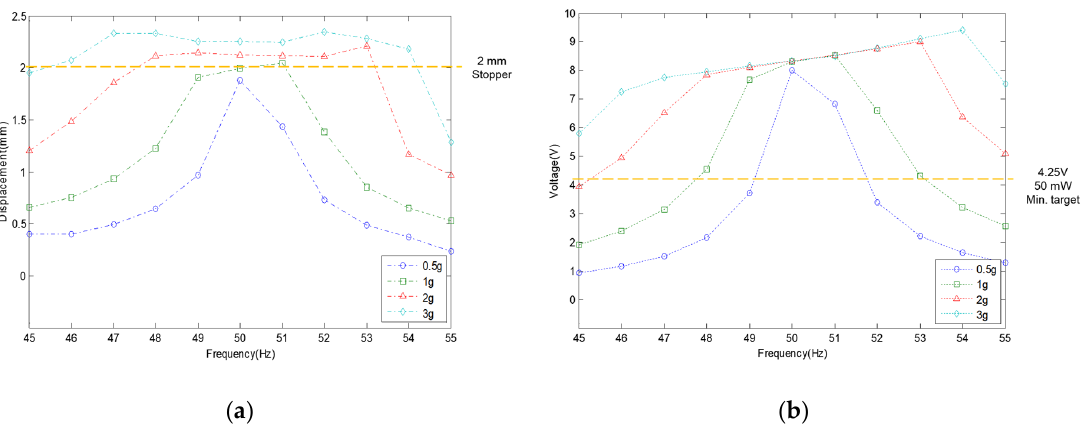
Figure 15. ( a ) The test results of the moving displacement for spring according to the vibration acceleration by the mechanical stopper, limited to 2 mm. ( b ) The RMS generated voltage with a 360 Ω load resistance (V rms-veh ) according to the vibration acceleration at one lower coil of the VEH device: a resonant frequency of 50 Hz was used under 0.5, 1.0, 2.0, and 3.0 G vibration acceleration conditions; the thickness of the spring was 1.0 mm.